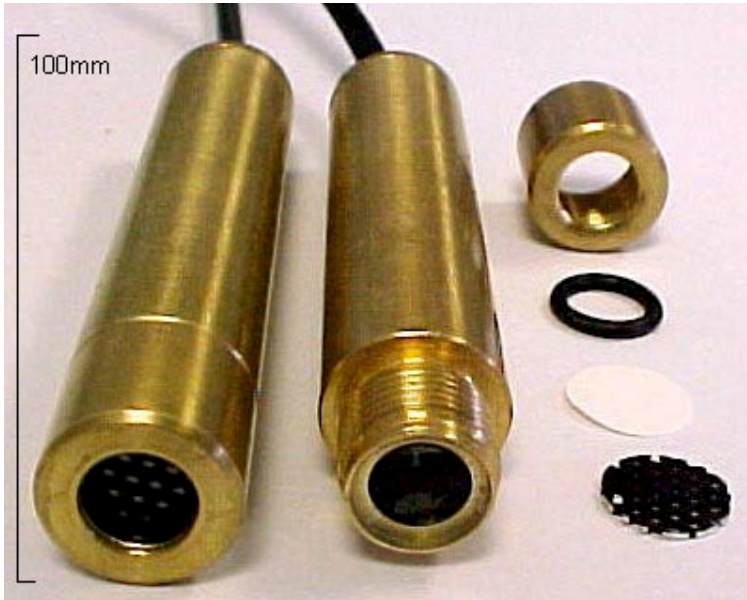
FIGURE 1. The sub-surface fuel sensor. The sensor on the right shows an exploded view of the sensor head assembly, exposing the NIR photoemitter/detector situated behind the glass face of the sensor